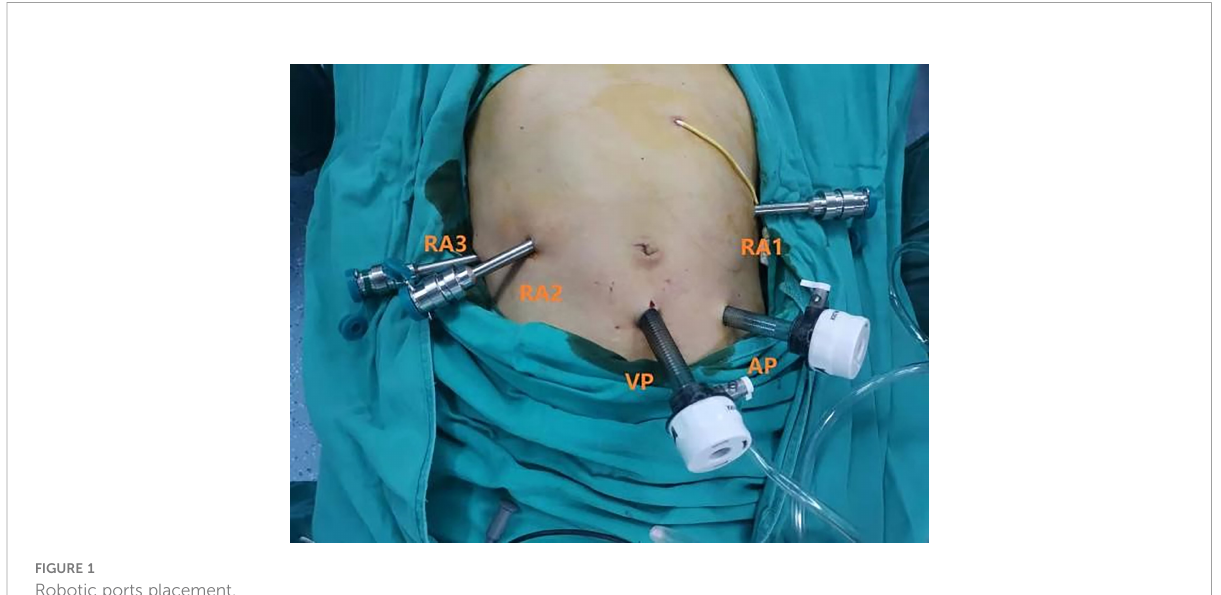
FIGURE 1 Robotic ports